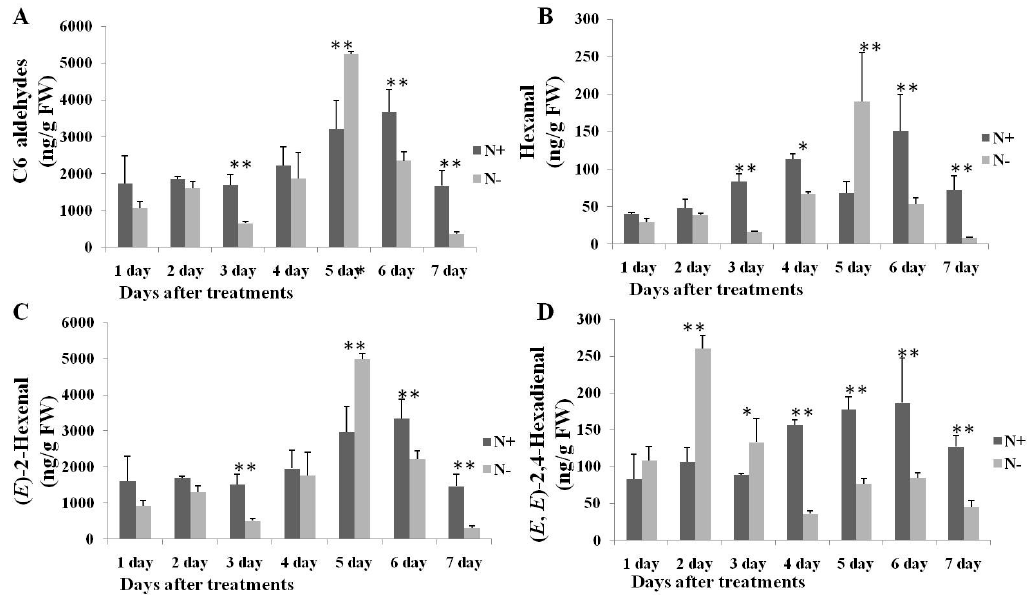
Figure 4. Changes in content of: C6 aldehydes ( A ); hexanal ( B ); ( E )-2-hexenal ( C ); and ( E , E )-2,4- Hexadienal ( D ) in 9930 leaves during N-deficient treatments. Bars present means ± standard deviations. * and ** mean significant difference from control at p < 0.05 and p < 0.01, respectively. N+ and N − mean nitrogen sufficient and nitrogen deficient treatments, respectively. Values are means of three replicates.